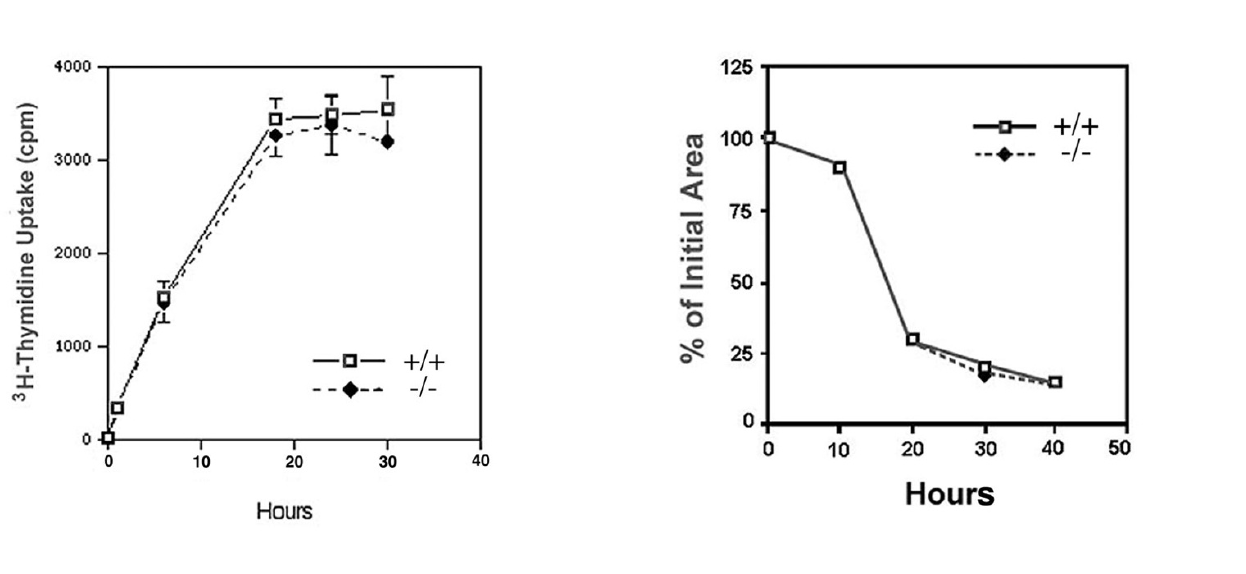
Incorporation of 3 H-thymidine by wild-type (+/+) and SPARC-null (-/-) dermal fibroblasts. Cells were plated and cultured overnight in DMEM containing 10% FBS. Cells were then washed with DMEM without FBS and incubated with 3 H-thymidine in DMEM containing 10% FBS. Data were derived from two independent experiments each performed in triplicate. Bars show mean ± SD.